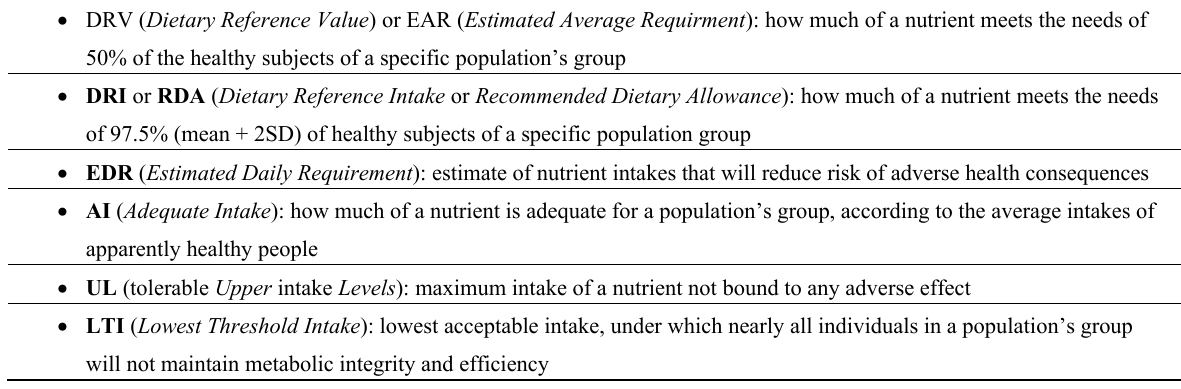
Table 1. Common Terms for Describing Nutritional